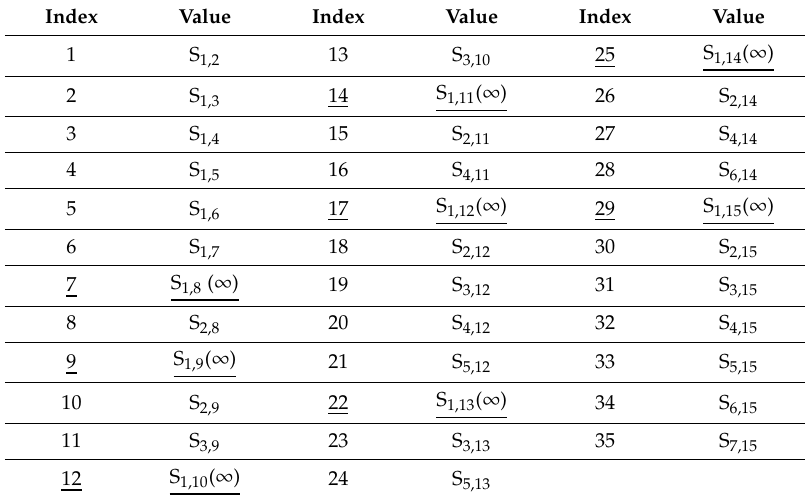
Table 2. Known connections for a given graph. Underline items identify key nodes.